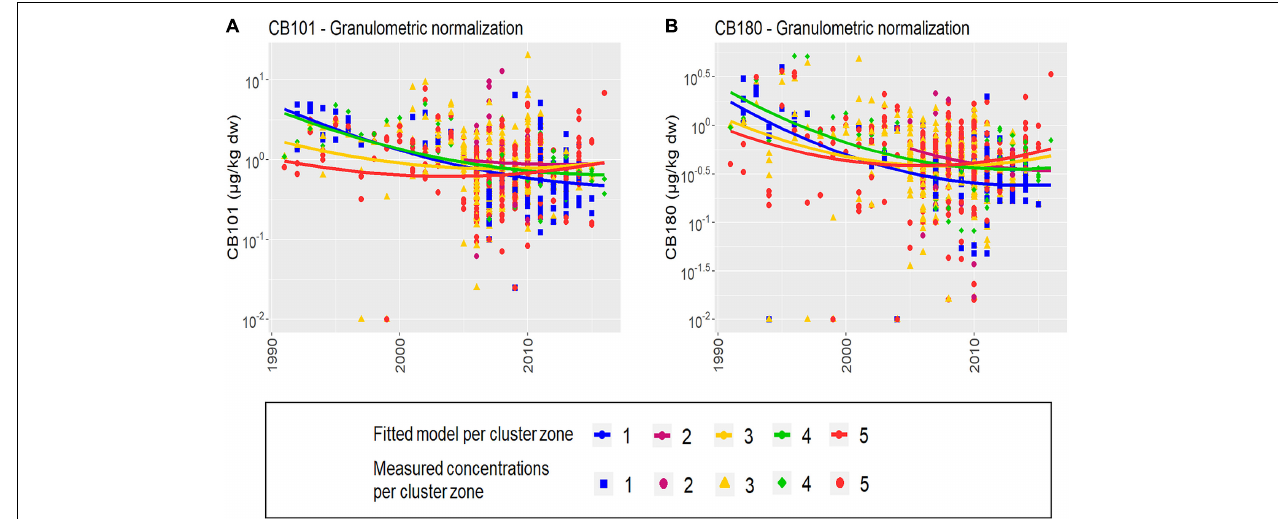
FIGURE 10 | Trends in PCBs in sediments of the BPNS based on granulometric normalization ( < 63 µ m sediment fraction). (A) CB101, (B) CB180. Colored regression lines represent the fitted time trends within each cluster zone, scaled to the first quadrimester and to the most recent analytical method.